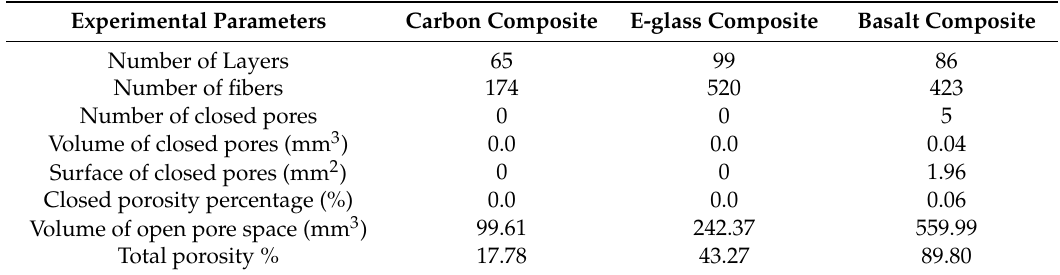
Table 3. Parameters for the analysis of 3D images of impacted composites in the µ CT techniques (pixel size: 16 µ